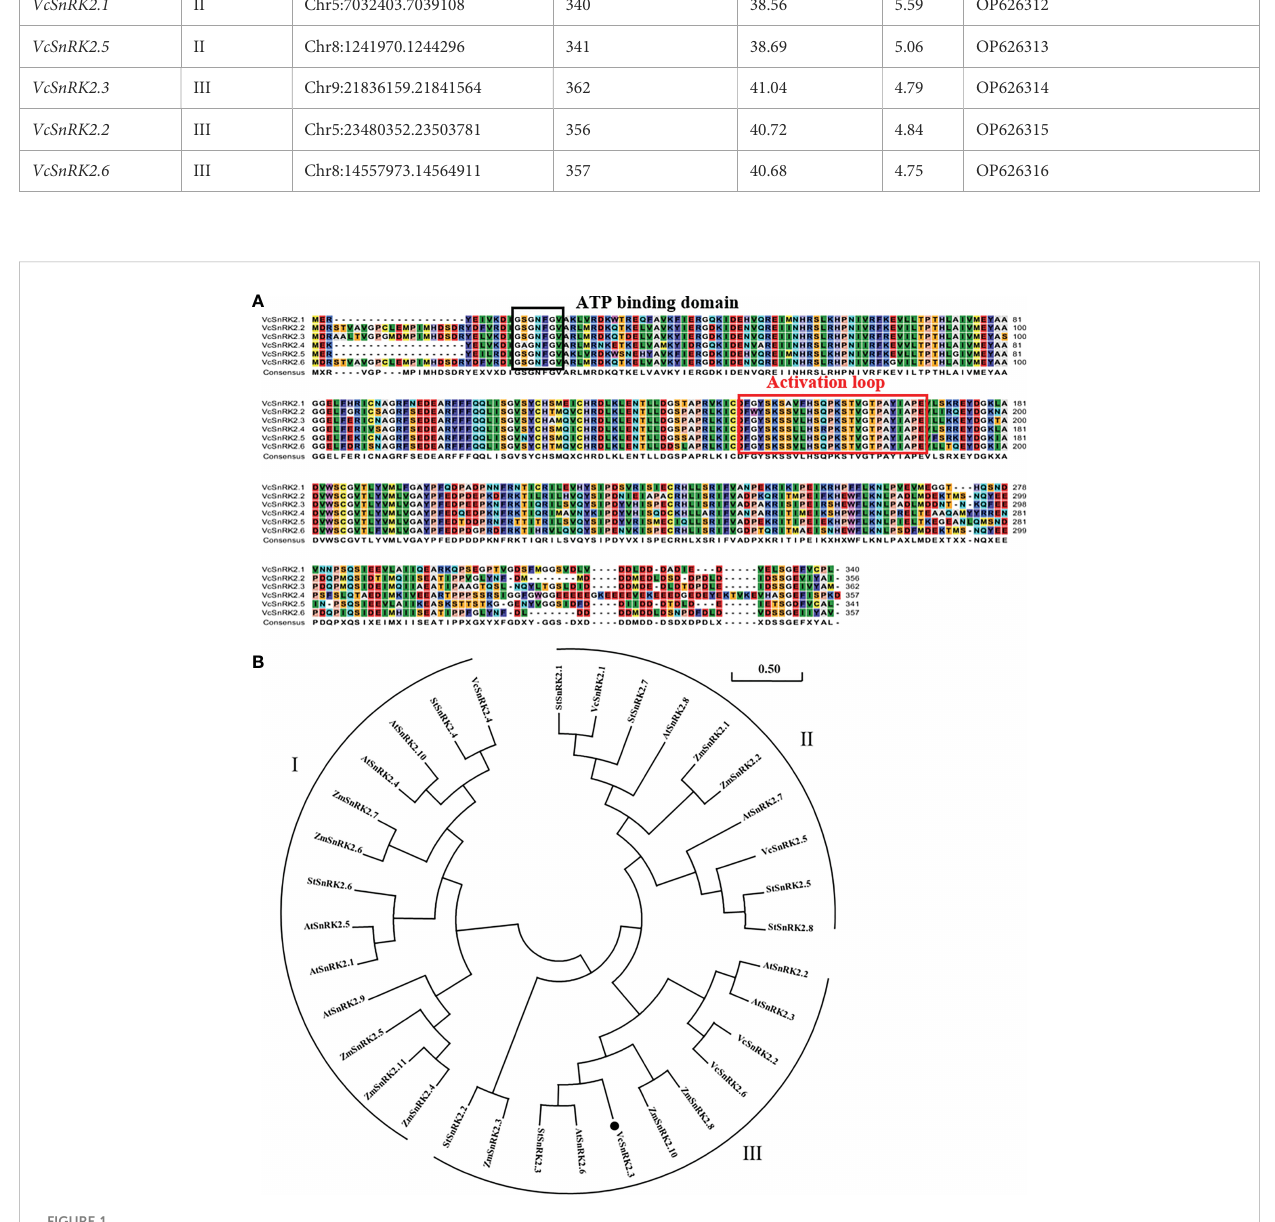
FIGURE 1 Sequence alignments and phylogenetic analysis of SnRK2.3. (A) Sequence alignments of the deduced amino acid sequences of VcSnRK2.1 to VcSnRK2.6 . The same color shading indicates the same amino acid residues. The deduced amino acid sequences of VcSnRK2s were aligned using CLC Sequence Viewer 6 software with the default settings. The predicted functional domains are boxed. (B) Phylogenic analysis of VcSnRK2 and its homologs in Arabidopsis, Solanum tuberosum and Zea mays . VcSnRK2.3 is denoted by the black spot. SnRK2 of Arabidopsis, Solanum tuberosum and Zea mays (AtSnRK2.1: AT5G08590.1; AtSnRK2.2: AT3G50500.2; AtSnRK2.3: AT5G66880.1; AtSnRK2.4: AT1G10940.2; AtSnRK2.5: AT5G63650.1; AtSnRK2.6: AT4G33950.1; AtSnRK2.7: AT4G40010.1; AtSnRK2.8: AtSnRK2.9: AT2G23030.1; AtSnRK2.10: AT1G60940.1; StSnRK2.1: JX280911; StSnRK2.1: